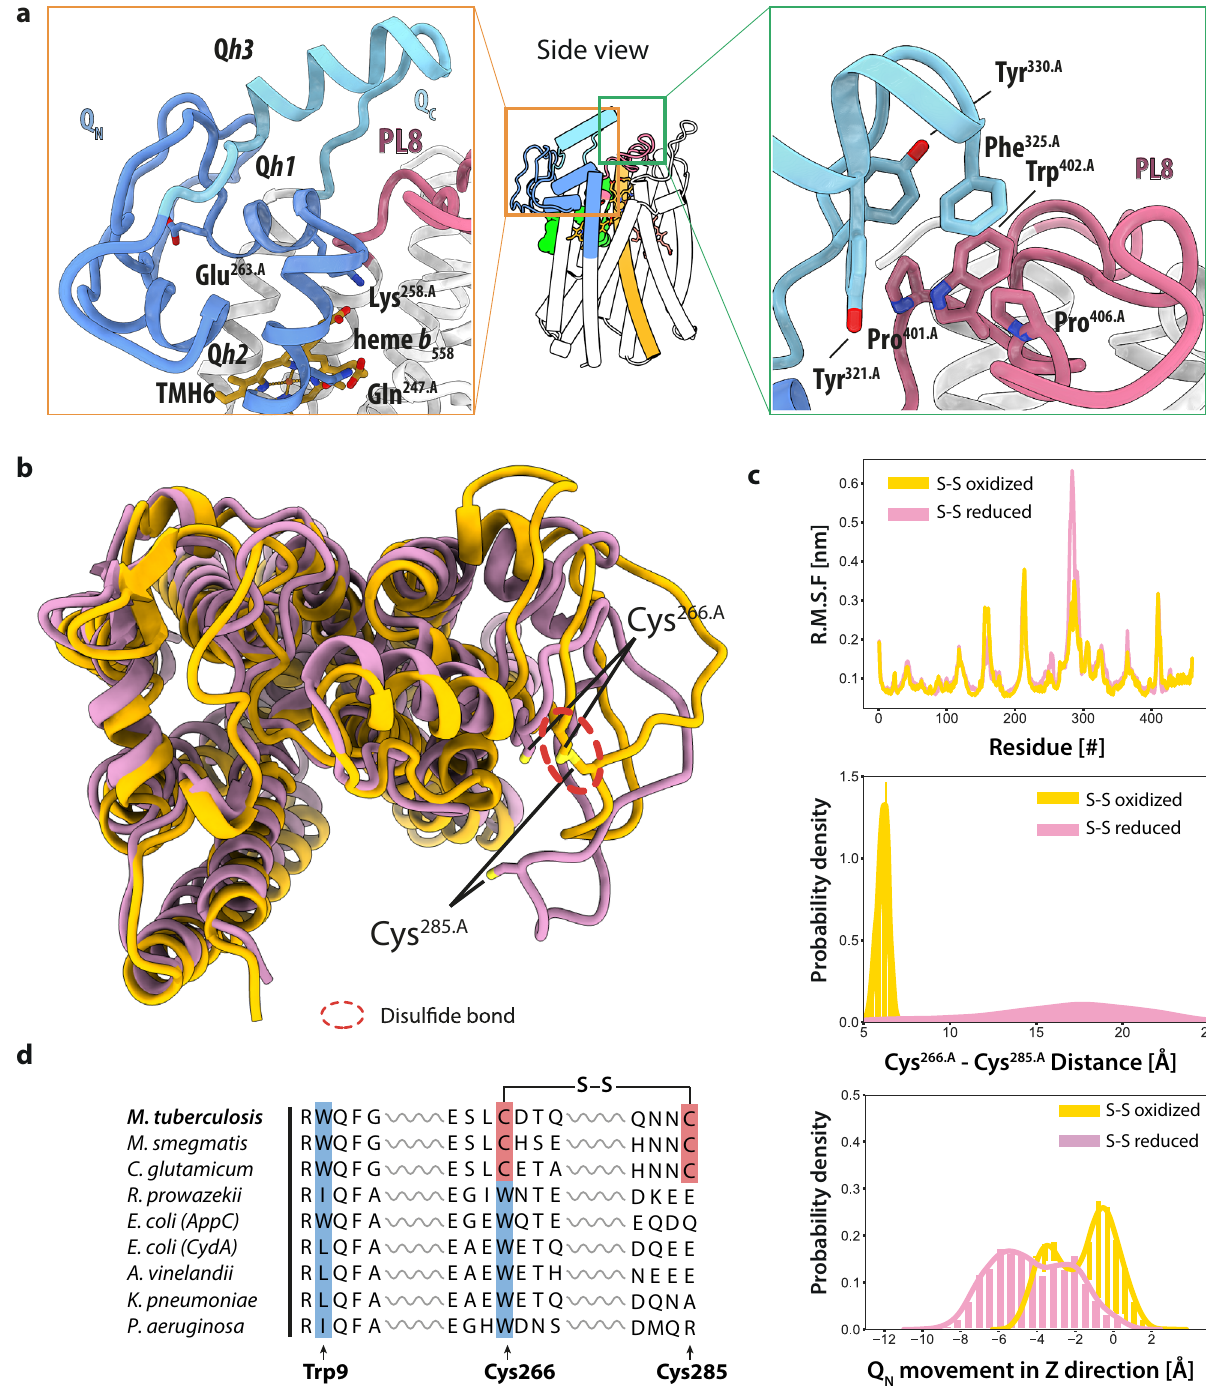
Fig. 3 Q-loop architecture of cyt. bd Mtb . a Left: The mycobacterial Q-loop is organized in a mostly disordered Q N (blue) and a rigid, well-ordered Q C segment (cyan). Q N starts at Pro 256.A and contains the horizontal helix Q h1 with the conserved residues Lys 258.A and Glu 263.A that covers heme b 558 , and a second small helix Q h2 comprising residues Tyr 296.A to Ala 303.A . The Q C segment is exposed to the periplasm and consists of the third Q-loop helix Q h3 that covers the surface of the TMHs 6 and 7. Right: Van-der-Waals interaction cluster between Q h3 and the periplasmic loop 8 (PL8) of CydA. b Top view of a superposition of CydA snapshots obtained from MD simulations performed in presence and absence of the Cys 266.A -Cys 285.A disul fi de bond. Positions of cysteine residues are indicated. The red dashed circle indicates the location of the intact disul fi de bond. CydA (oxidized), yellow; CydA (reduced), violet. c Top: average root mean square fl uctuation plot of CydA residues in MD simulations for 2 × 750 ns with reduced and oxidized disul fi de bond (Cys 266.A - Cys 285.A ) of the Q N -loop. Middle: Data plots of C α -C α distance distribution between disul fi de-forming cysteines during MD simulations. Bottom: Distribution of Q N displacement in Z direction during MD simulations. Yellow data plots indicate a simulation setup with intact disul fi de bond. Purple data points indicate a simulation setup with a reduced disul fi de bond. d Sequence alignment of representative cytochrome bd